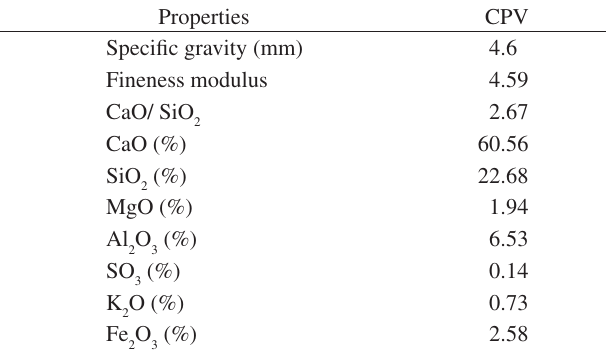
Table 1. Physical and chemical compositions of Portland cement – type V.